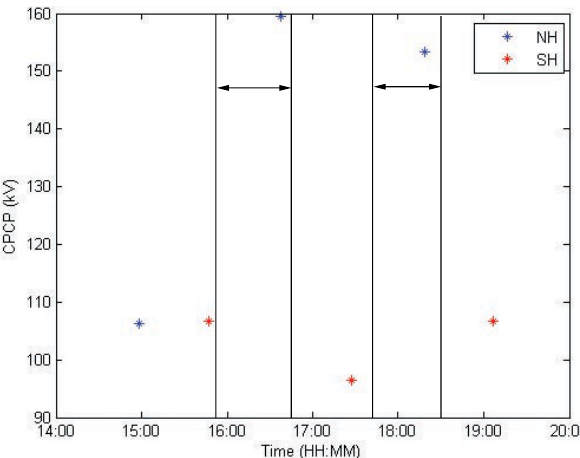
Fig. 14. CPCP estimates derived from F13 cross-track ion drift ob- servations across the polar cap in both hemispheres. Two intervals of enhanced substorm activity are marked by vertical